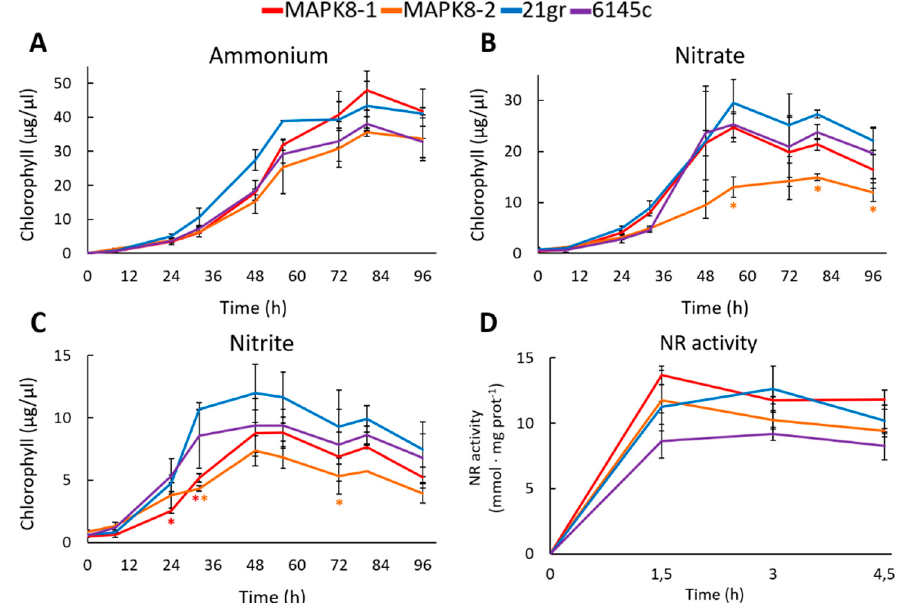
Figure 5. Growth and NR activity in mapk8 and wt strains. Two mapk mutants ( mapk8-1 and mapk8-2 ) and two wt (6145c and 21gr) strains were grown in the following media ( A ) 8 mM ammonium, ( B ) 4 mM nitrate, and ( C ) 2 mM nitrite and at the indicated times samples were taken to quantify the chlorophyll. ( D ) The indicated strains were grown in ammonium until de exponential phase of growth, afterward the cultures were induced with 4 mM nitrate and at the indicated times samples were taken to measure the NR activity. Error bars indicate the standard deviation of three biological replicates. Comparisons were made by the Student’s t -test. Statistical di ff erences (* p < 0.05) are shown between a mapk8 mutant and both wt strains of the same time point. The red and orange asterisks represent statistically significant di ff erence with mapk8-1 and mapk8-2 respectively.